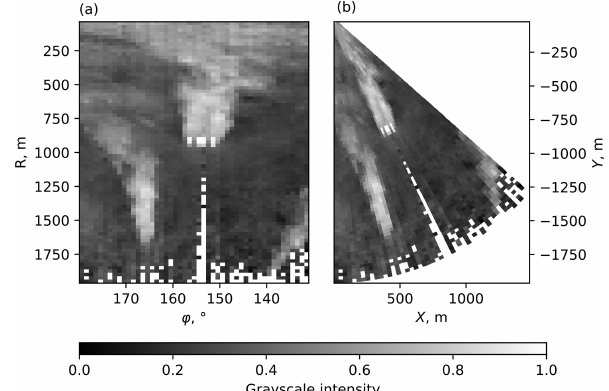
Figure 3. Comparison of the mean radial wind speed and the refer- ence wind direction in the data